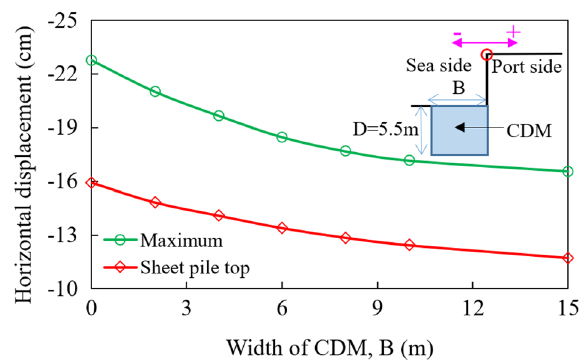
Fig. 12 Change of horizontal displacement with the width of CDM (the Coalinga motion)